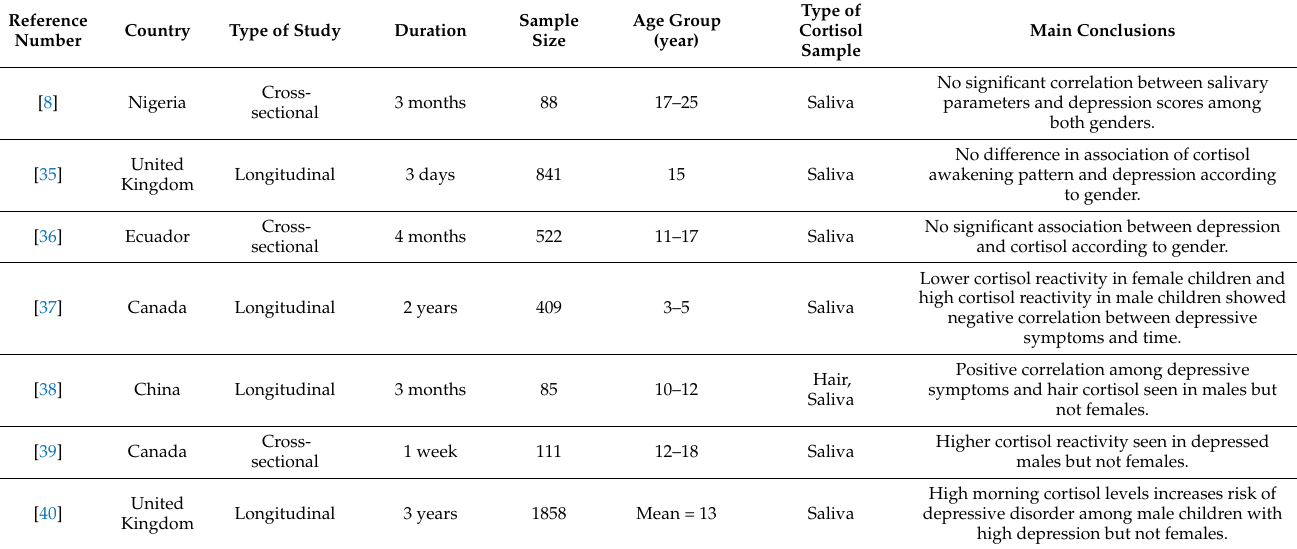
Table 1. Salivary mixed-gender studies investigating the relationship between cortisol and